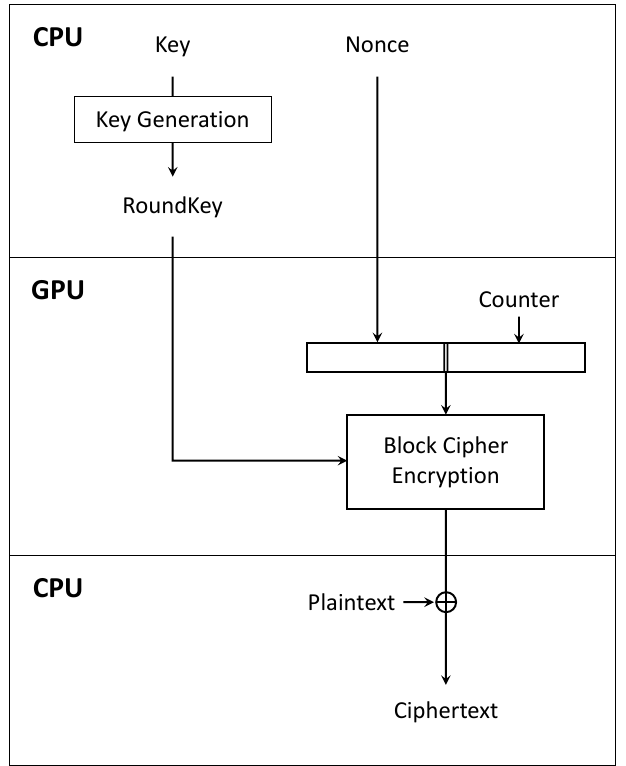
Figure 6. Block cipher counter modes of operation in GPU